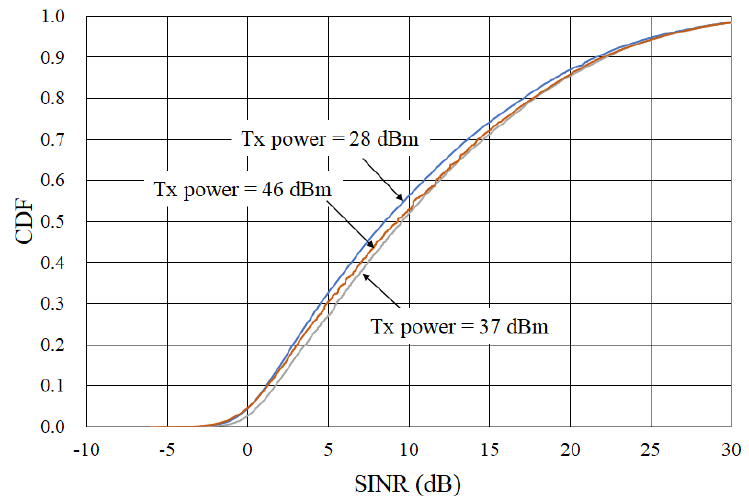
Figure 6. CDF of downlink effective SINR as a function of three pico-eNB Tx powers.